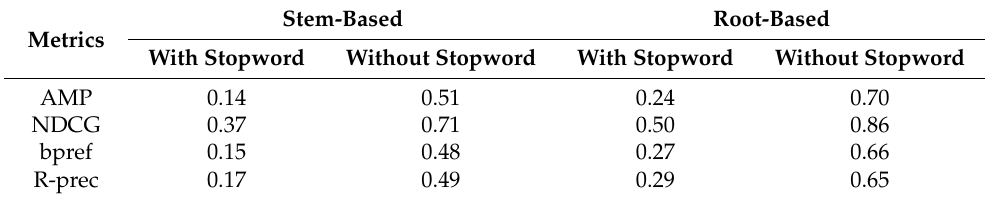
Table 8. Stem-based and root-based retrieval with and without stopwords on 2AIRTC.